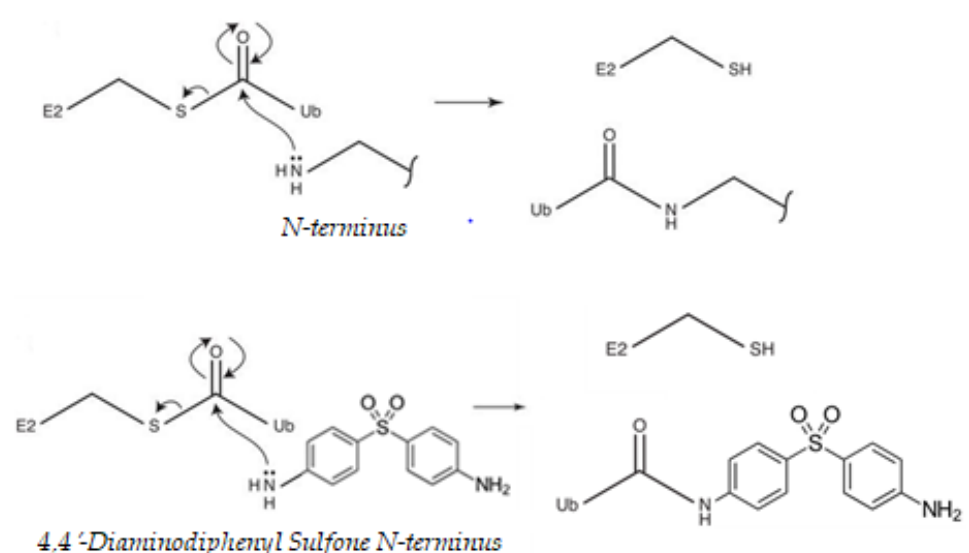
Figure 1. Nucleophilic properties of ,4′-diaminodiphenyl sulfone (DDS). Proteins contain many nucleophilic sites capable of attacking a ubiquitin (Ub)-conjugating enzyme (E2)–Ub thioester linkage and undergoing ubiquitination. The best-described sites are the amine-containing internal lysine residues and the free amine of the N-terminus of the polypeptide backbone. Ub is activated by an Ub-activating (E1) enzyme, using energy from ATP hydrolysis, and passed to an Ub-conjugating (E2) enzyme. Ub can then be passed to a substrate protein, specified by the distinct E3 ligase that binds both the substrate and the E2. DDS can compete with the ubiquitination cascade. Cysteine thiols and hydroxyls on serines, threonines, leucines, and tyrosines could also potentially be ubiquitinated by an identical mechanism